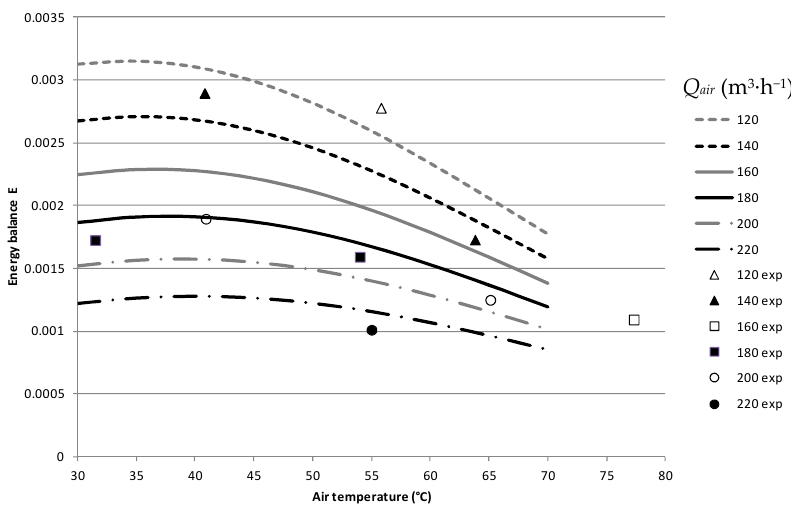
Figure 7. Energy balance ( E ) versus air temperature and flow rate (DOE equation (line) and experimental tests (points)).